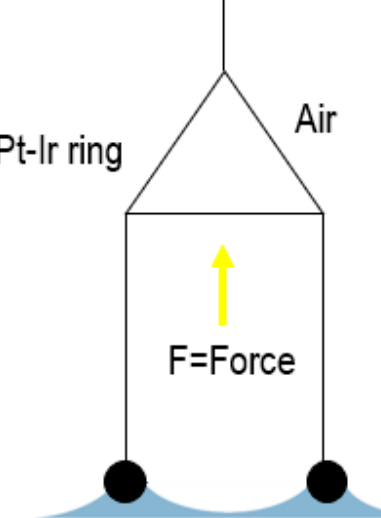
Figure 12. Du Noüy ring method. The force (yellow arrow) referring to the wetted length acting on a ring as a result of the tension of the withdrawn liquid lamella when moving the ring from one phase to another is measured via this method. Source: the